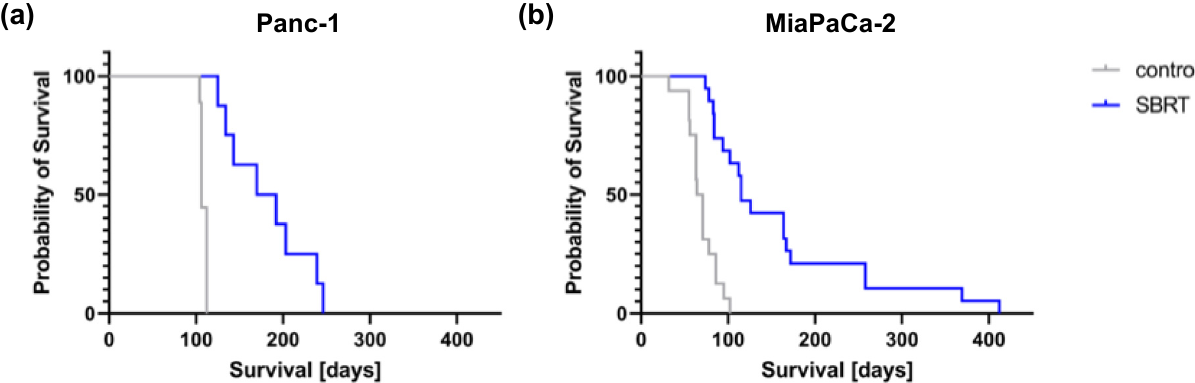
Figure 5. Kaplan–Meier survival curves after 25 Gy SBRT and unirradiated tumor-bearing control mice ( p < 0.0001) after orthotopic injection of Panc-1 ( a ) and MiaPaCa-2 cells ( b ).